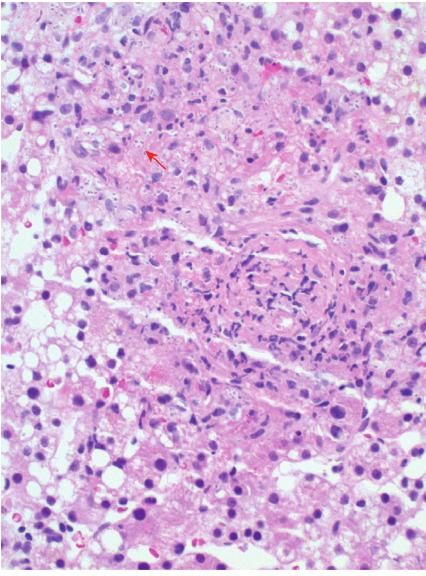
Figure 1: Hematoxylin and eosin stain. Liver biopsy showing noncaseating granulomas and intracellular fungal organisms.